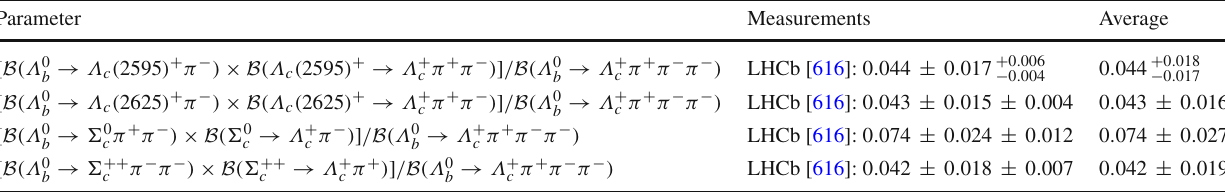
Table 216 Relative decay rates to excited or (cid:29) c states